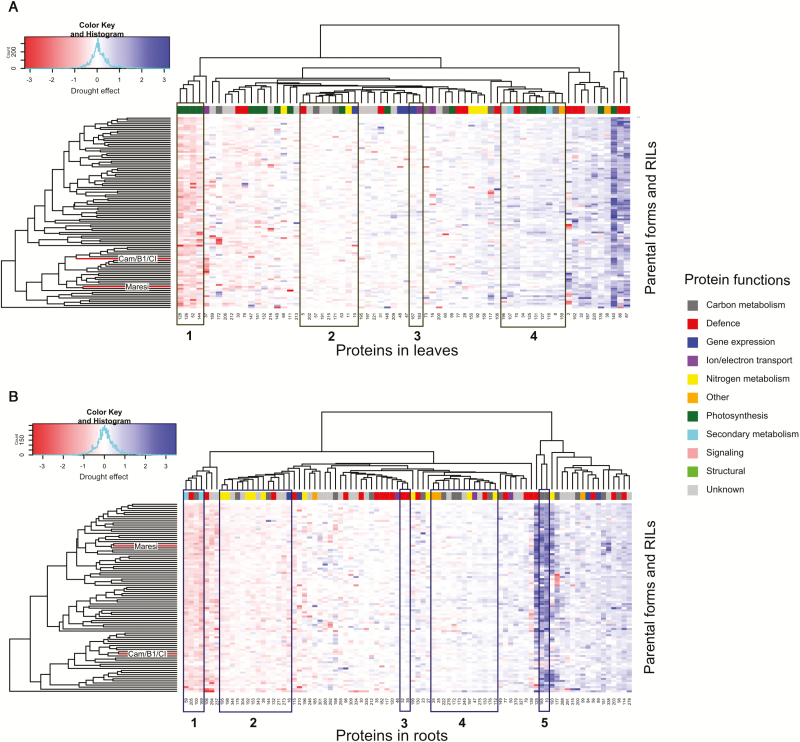
Hierarchical clustering analysis visualization of drought effects for leaf (A) and root (B) proteins exhibiting significant G×E interaction with minimum of 60 observations in all tested genotypes. Protein clusters for which a statistically similar reaction to drought was noted are marked by boxes. Parental lines are marked with red branches.